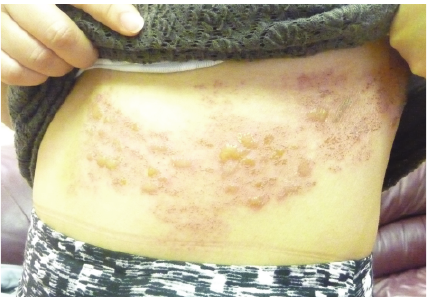
Figure 1: Bilateral, symmetrically distributed herpes zoster lesions along T7, T8, and T9